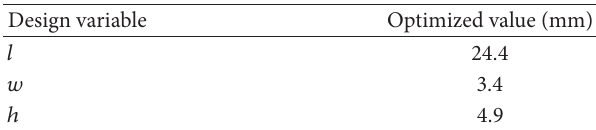
Table 1: The result of optimization.